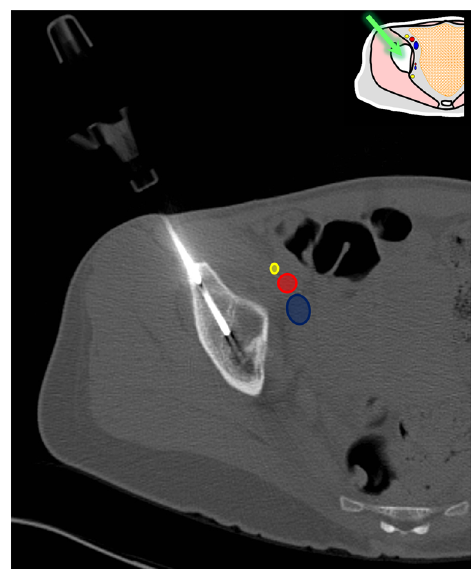
Fig. 11 A 49-year-old woman treated for lung cancer presenting with several new lytic bone lesions and right hip pain. An anterolateral ap- proach through the anterior iliac border was used and the biopsy with an 11-G bone biopsy needle confirmed lung metastasis. During the same procedure, a cementoplasty was performed to relieve the pain and reduce the risk of fracture (not shown)